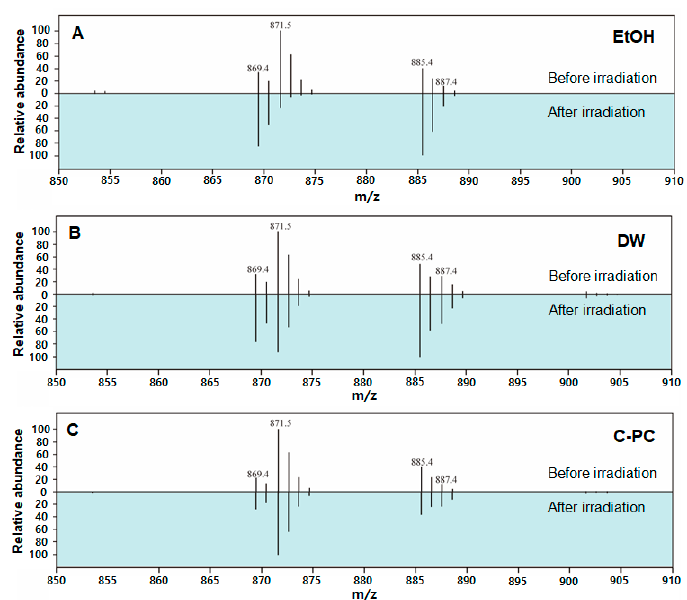
Figure 2. APCI-MS spectra acquired in the m/z range of 850 and 910 before (top) and after (bottom) intense light illumination of extracts from Chlorella vulgaris in three different media, namely, ( A ) EtOH, ( B ) DW, and ( C ) C-PC. Mass spectra were acquired using the centroid mode. Table 1. Definition of the abbreviations of chlorophyll a derivatives shown in Figure 2.